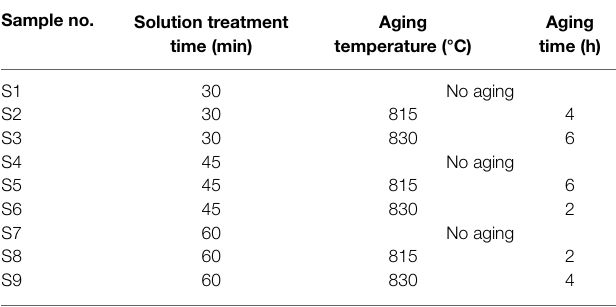
TABLE 1 | Experimental parameters used in the present investigation